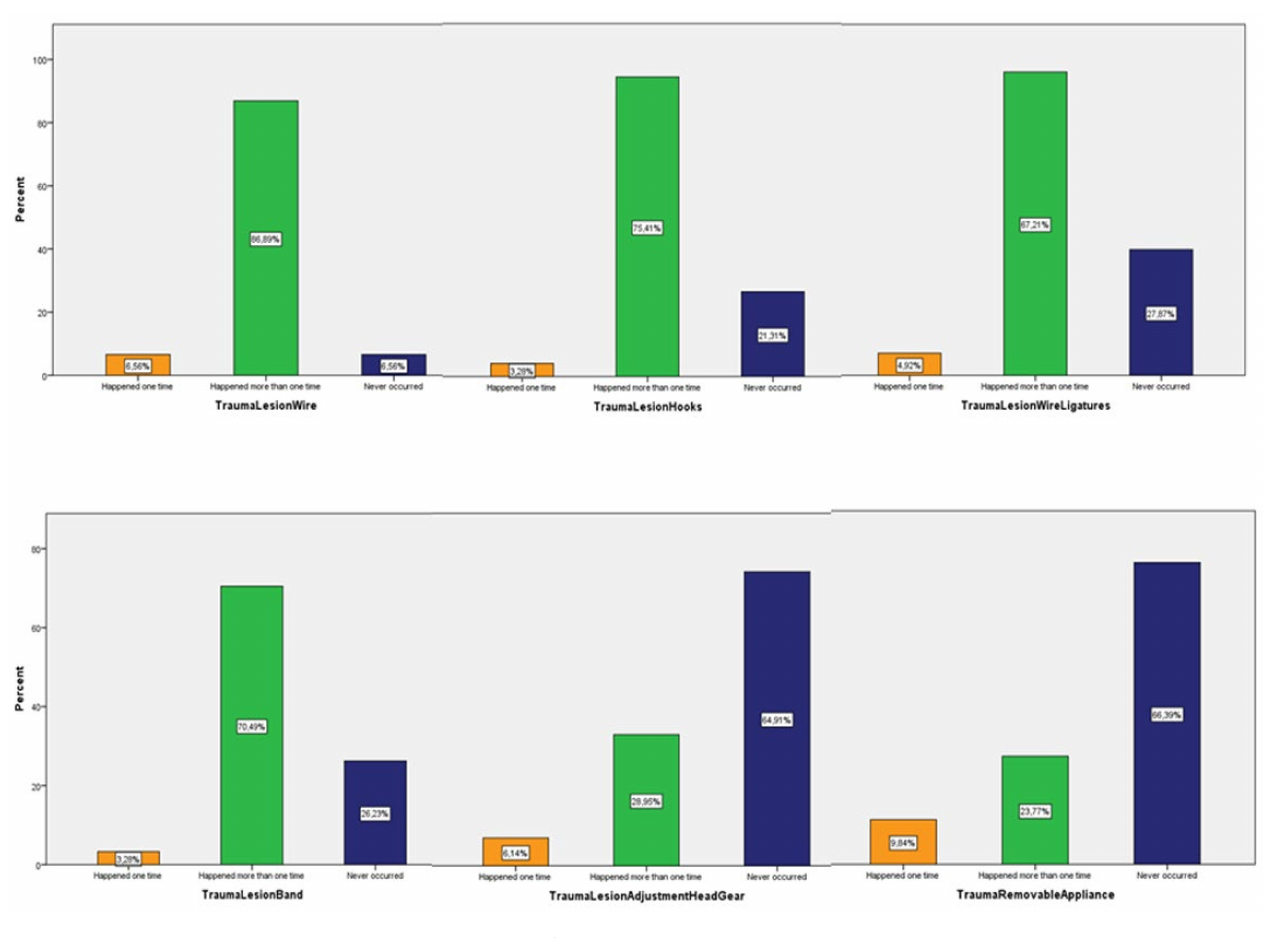
Figure 6. Traumatic incidents.